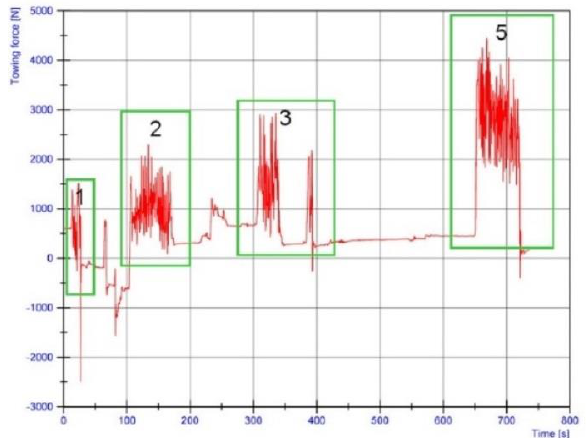
Figure 6. Towing forces for 1, 2, 3 and 5 biomass bales measured during the biomass train field trials at the Byszewice site (NI